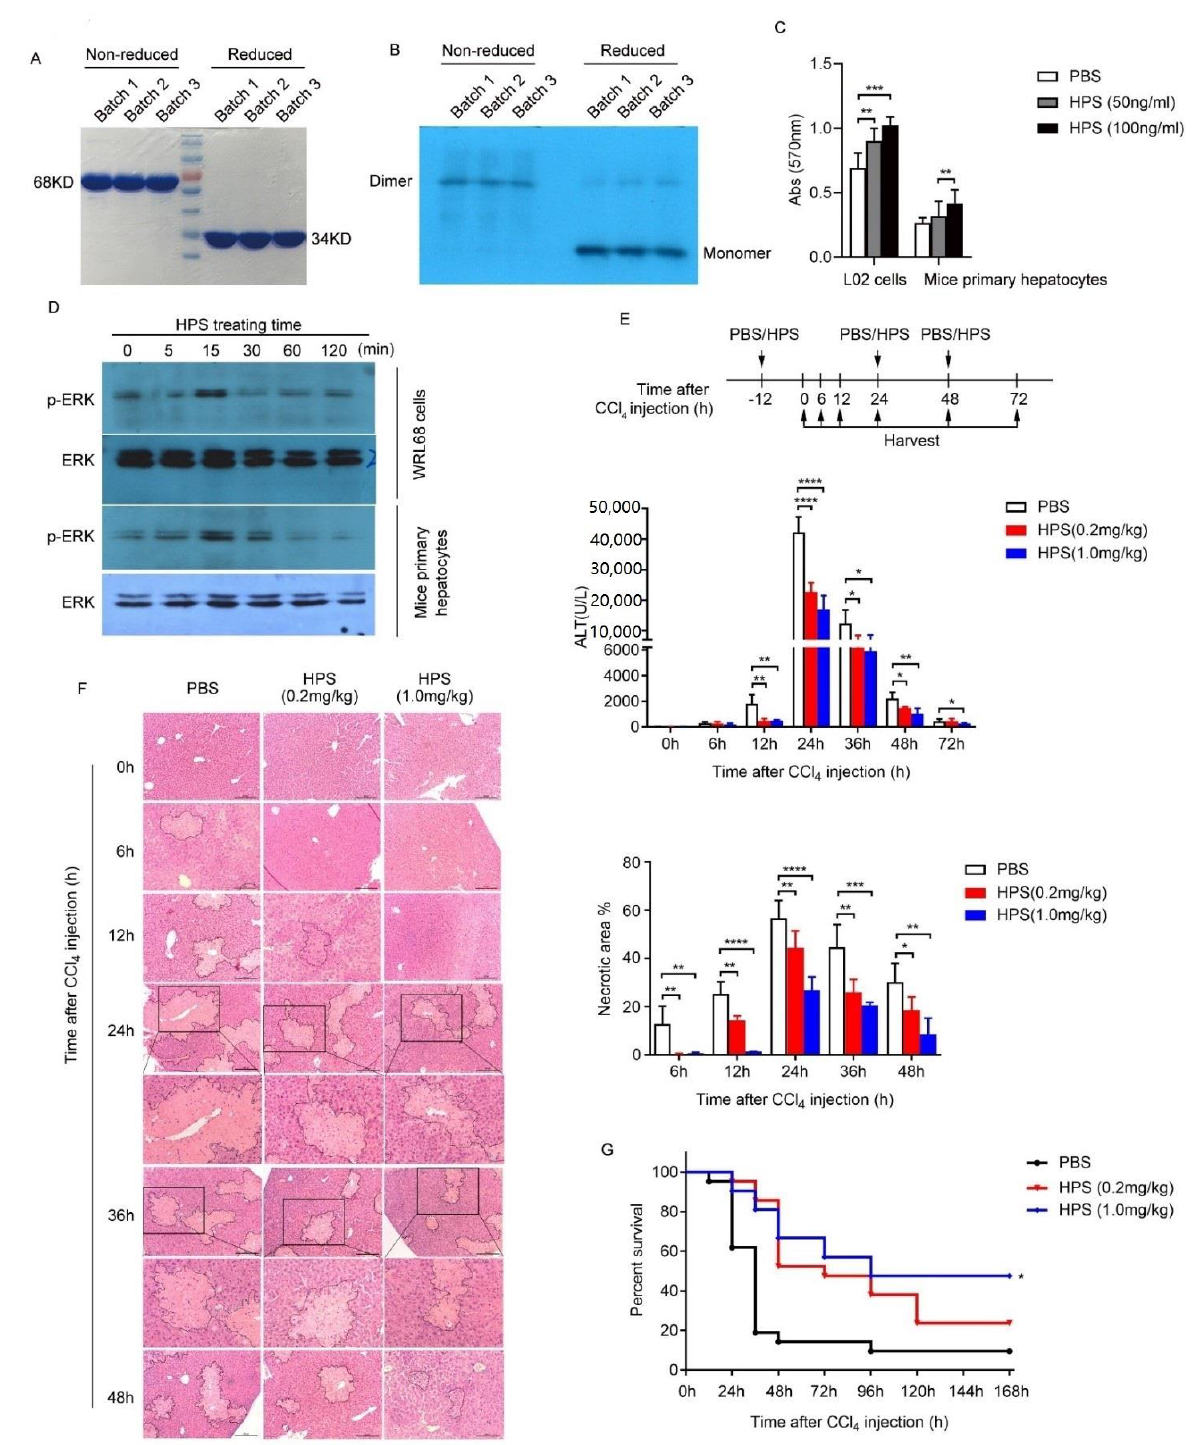
Figure 1. Expression and characterization of recombinant human hepassocin produced by CHO cells. ( A ) SDS-PAGE analysis of purity of 3 batches of HPS protein. The HPS molecular weight of the naturally active form (dimer form) is 68 KD and the molecular weight of the monomer is 34 KD. ( B ) Immunoblotting analysis of HPS protein using human HPS antibody. ( C ) WRL68 cells and primary hepatocytes were treated with 50 or 100 ng/mL HPS as indicated for 24 h. MTT was performed to detect cell proliferation. Data are represented the results of three independent experiments and expressed as mean ± SEM. A Student’s t -test was used to compare the mean relative values between groups. (** p < 0.01, *** p < 0.001). ( D ) WRL68 cells and primary mouse hepatocytes were serum starved overnight, following by treated with 100 ng/mL of HPS for indicated times. Immunoblotting was performed to detected ERK phosphorylation. Total ERK was used as